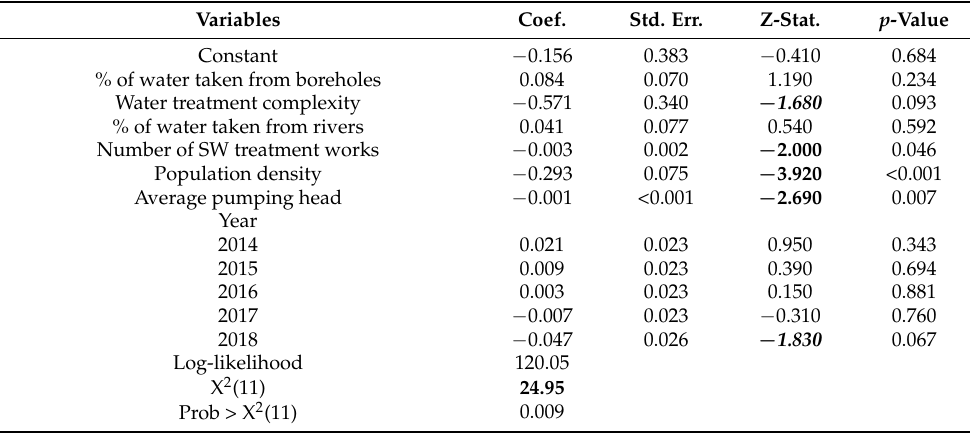
Table 6. Estimates of Tobit regression: variables affecting eco-efficiency scores. Variables Coef. Std. Err.